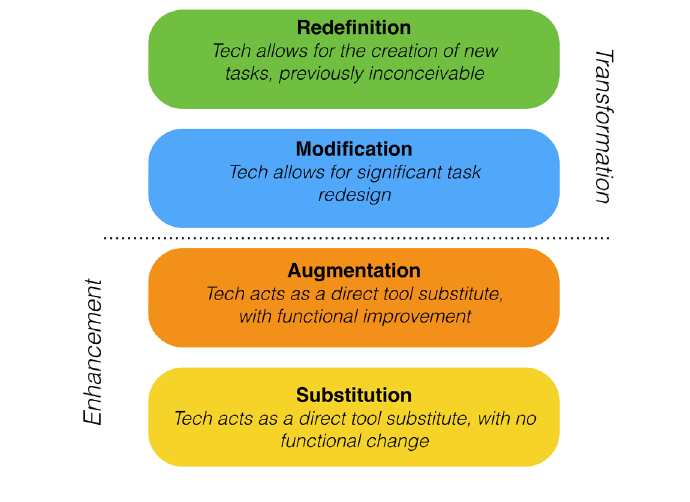
Fig. 13. Classification of both frameworks show classification of learning methods and corre- sponding